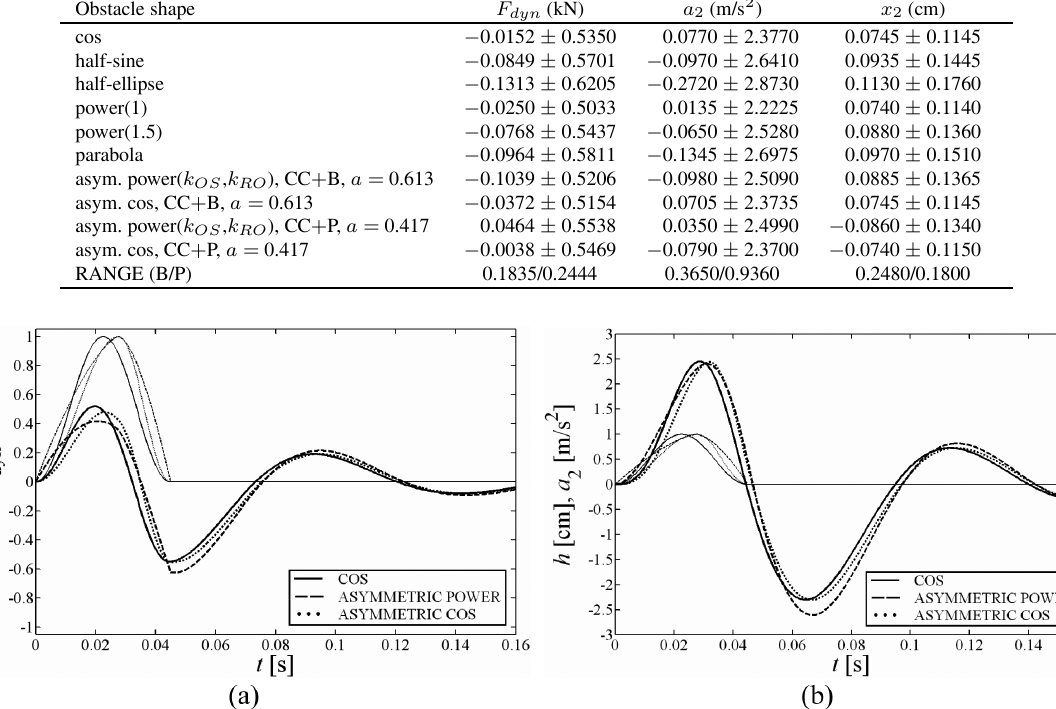
Fig. 8. Time vibration response of a quarter-car model (thick lines) to bump (thin lines): (a) dynamic tyre force, F dyn ; (b) sprung mass acceleration, a 2 . 600 Ns/m, giving the corresponding undamped natural frequencies, f 1 = 11 Hz, f 2 = 1.21 Hz, and the damping ratio D 2 =